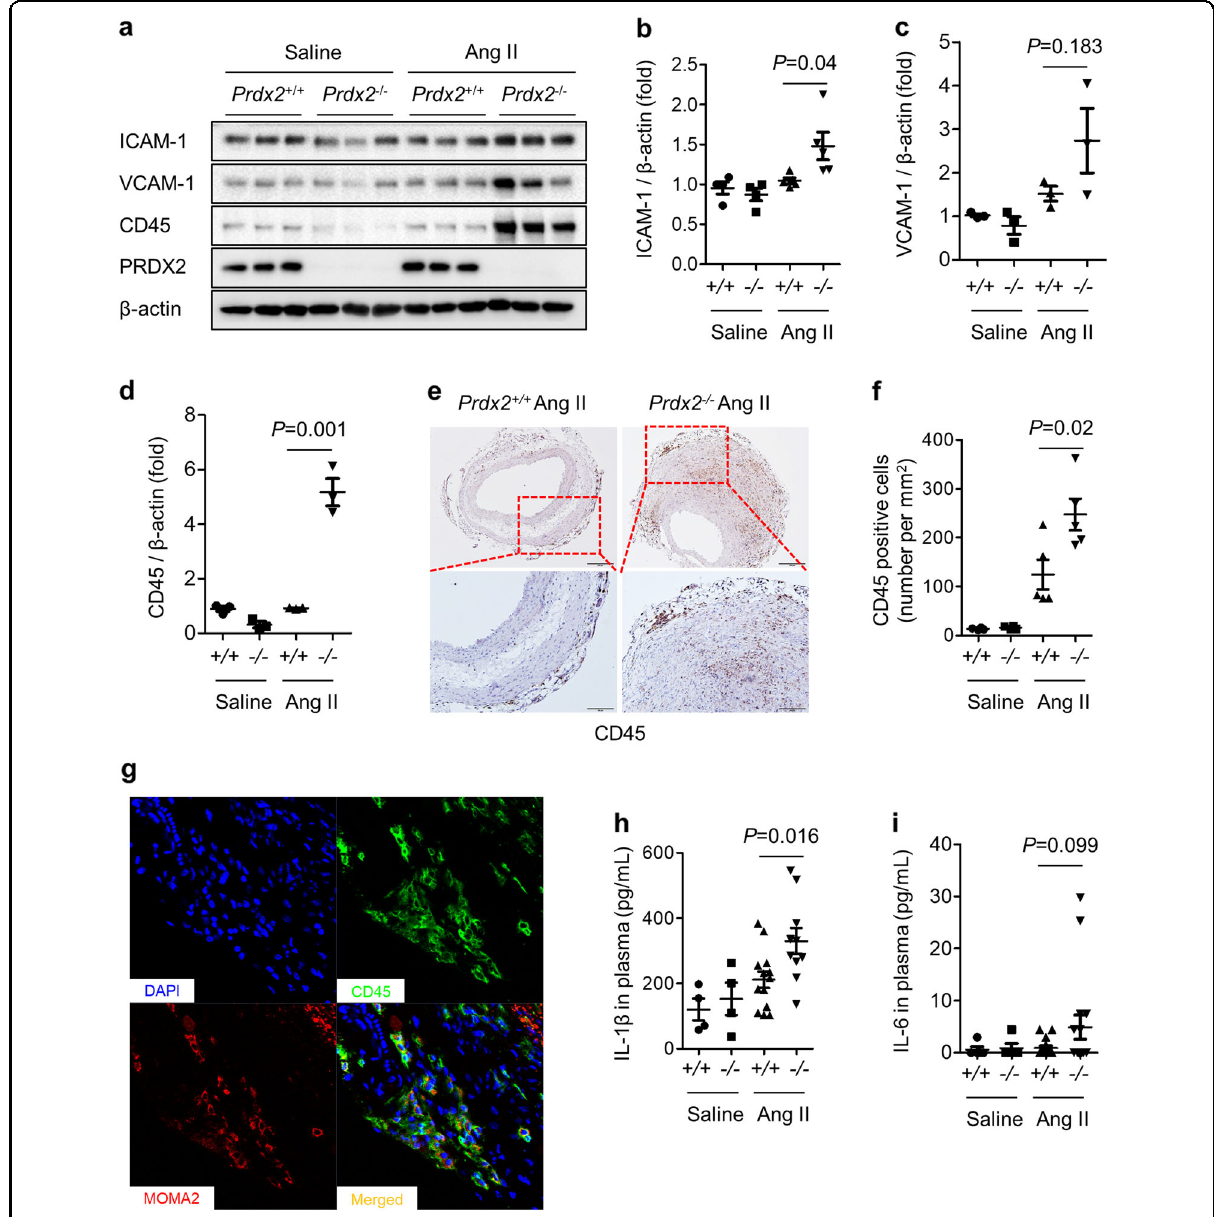
a Immunoblotting analysis of ICAM-1, VCAM-1, CD45, and PRDX2 in aortas from Prdx2 + / + and Prdx2 − / − mice infused with saline or Ang II for 4 weeks. β -actin was used as a loading control. b Quanti fi cation of ICAM-1, c VCAM-1, and d CD45 in Fig. 6a. Data are presented as the mean ± SEM (two ‐ tailed Student ’ s t test). e Representative immunostaining images showing the accumulation of immune cells in aneurysmal lesions. Cross-sectional images of CD45 immunostaining (top; scale bar, 200 µm) and higher magni fi cation of the boxed area (bottom; scale bar, 100 µm). f Quanti fi cation of CD45-positive cells using images of abdominal aortic cross-sections (saline groups, n = 3; Ang II groups, n = 5). Data are presented as the mean ± SEM (two ‐ tailed Student ’ s t test). g Representative confocal images of immune cells (CD45) and macrophages (MOMA2) in aneurysmal aortas. Scale bar, 50 µm. h The levels of IL-1 β and i IL-6 in plasma from Prdx2 + / + and Prdx2 − / − mice infused with saline